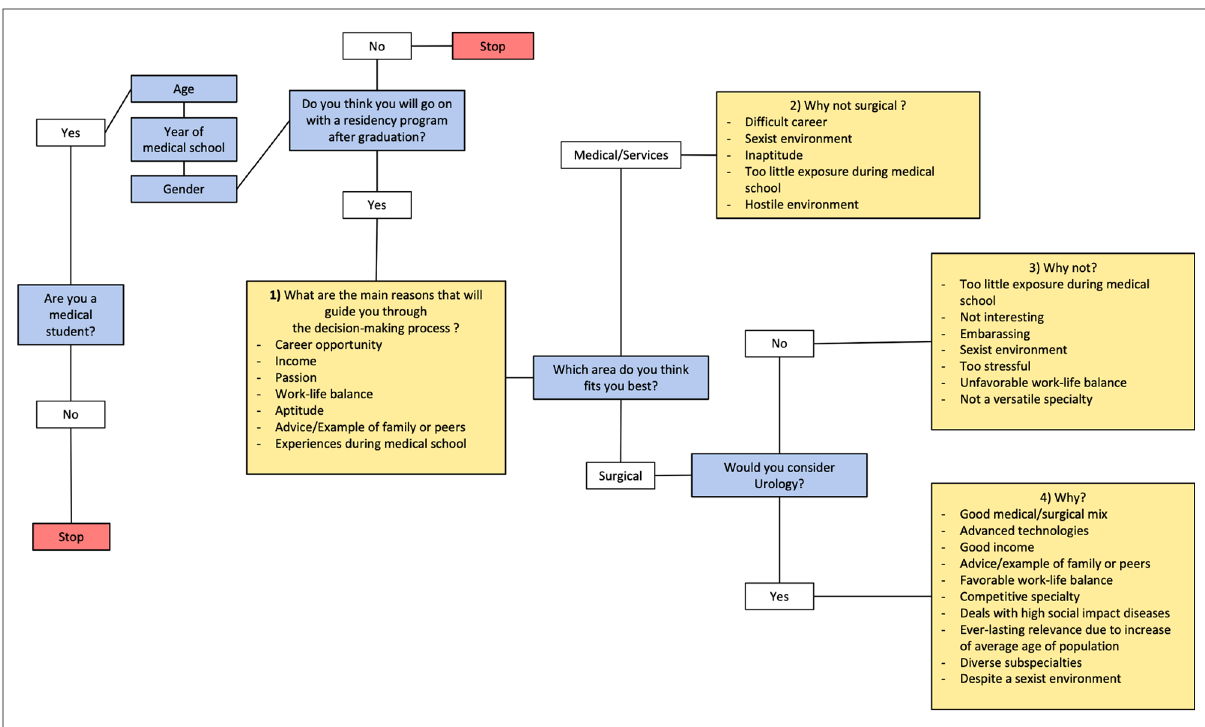
FIGURE 1 Overview of a questionnaire structure, with multiple-choice questions given in blue and Likert-scale questions given in